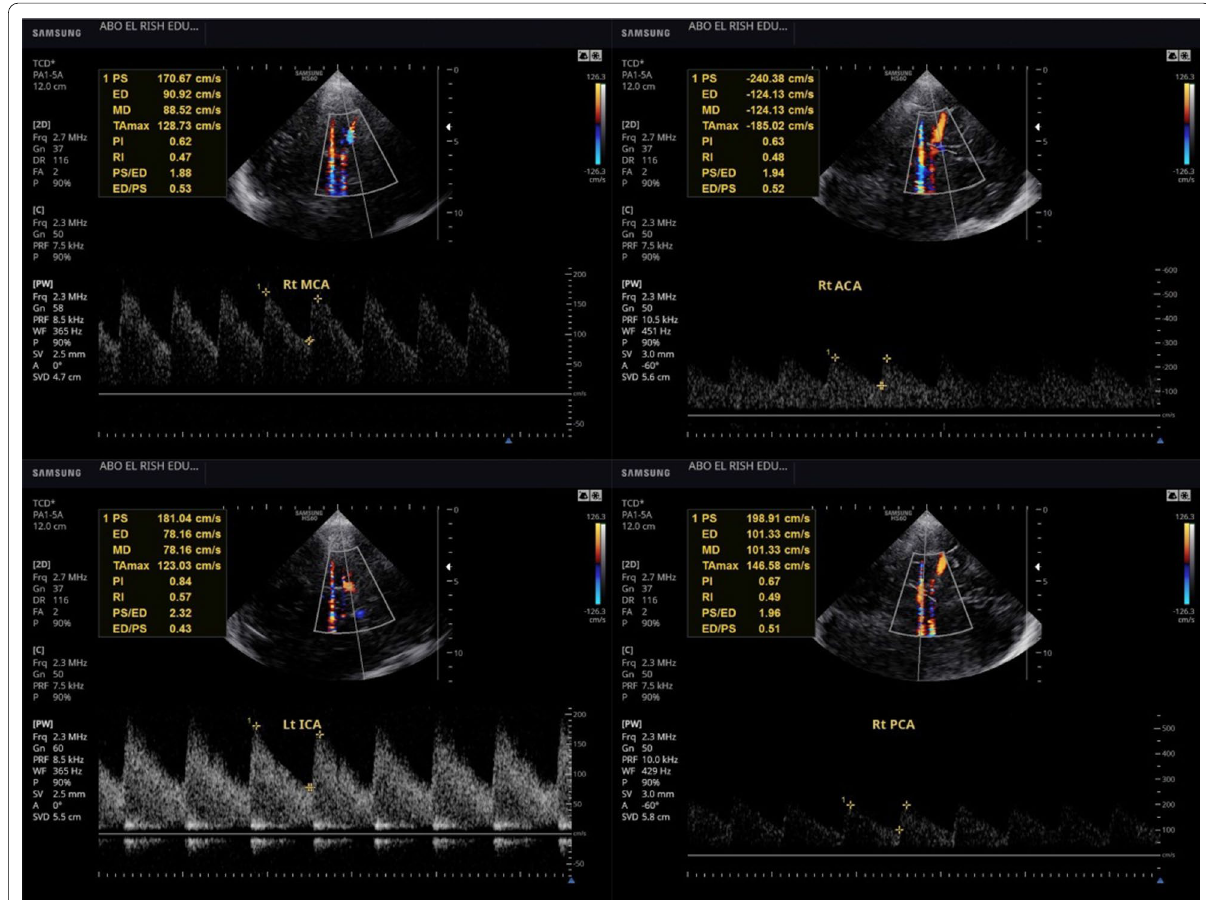
Fig. 4 8 years old female patient on occasional blood transfusion, Transcranial Doppler measurements showing right MCA TAmax of 128 cm/sec, left MCA TAmax of 150 cm/sec, right ACA TAmax of 185 cm/sec and Rt DICA TAmax of 165 cm/sec, parameters indicating conditional risk of